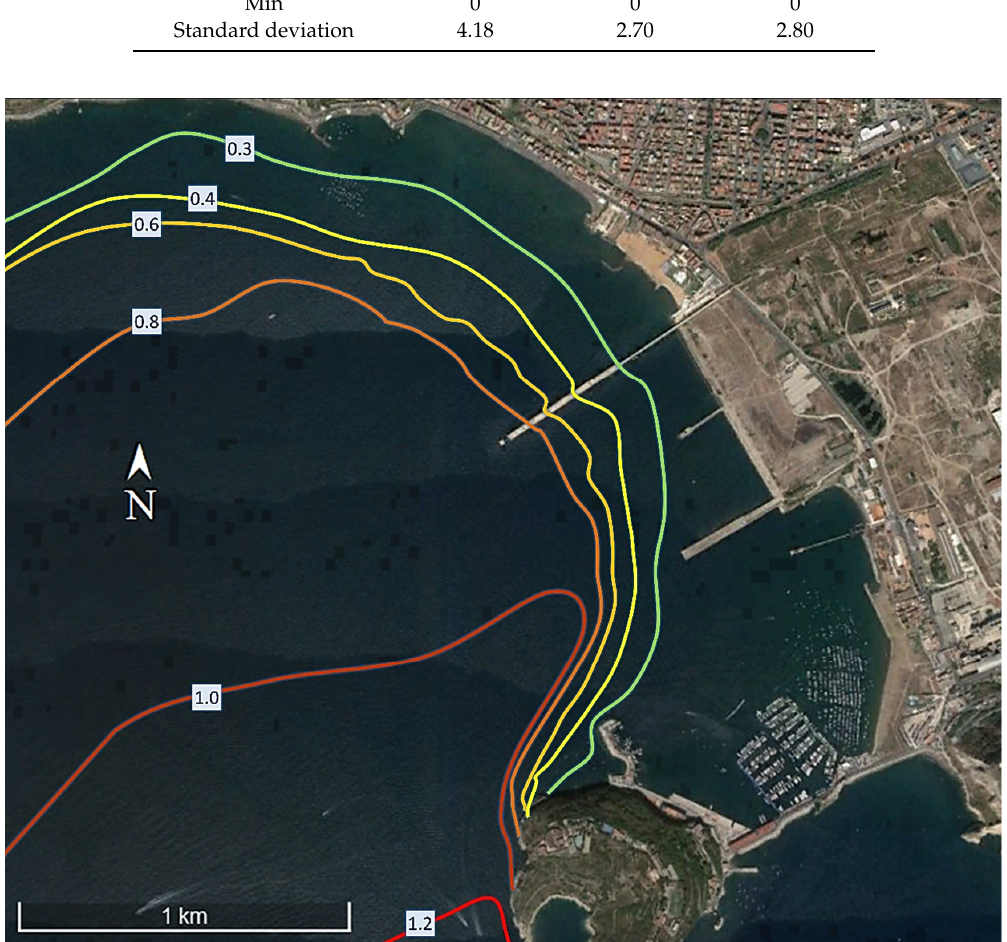
Figure 16. Mean wave power flux per unit crest (expressed in kW/m) in the Bagnoli-Coroglio Bay.